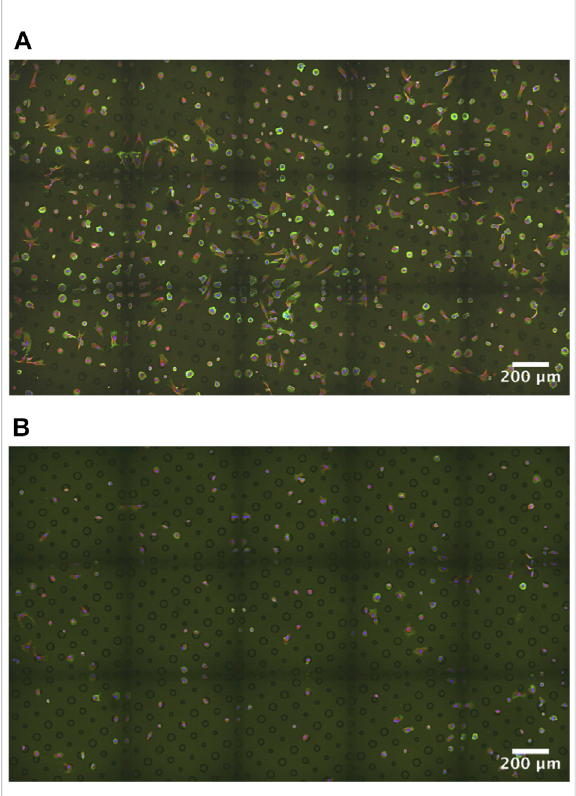
FIGURE 1 Dupuytren fi broblasts plated on the three circular micropatterns of different diameters. Adhesive proteins (A) fi bronectin and (B) collagen I. Fibroblast labeling: actin in green, vimentin inred,and nuclei in blue. SupplementaryFigures S9, S10: control and scar fi broblasts plated on the three circular micropatterns of different diameters ( fi bronectin